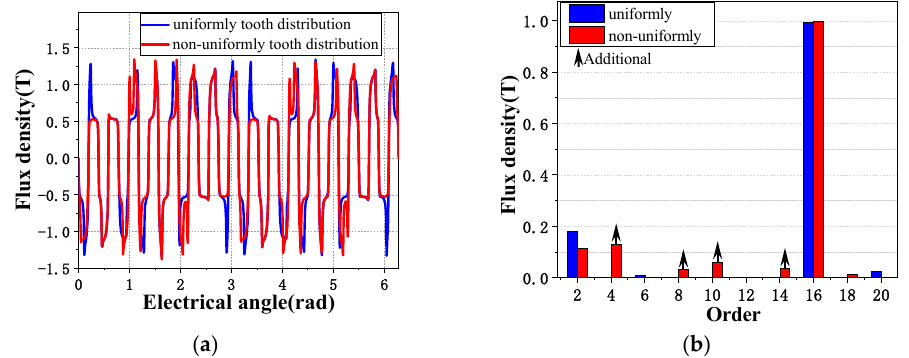
Figure 14. Comparison of airgap flux density by FEM: ( a ) flux density waveform; ( b ) spectra of FFT. The back-EMF is simulated in no-load condition at 50 rpm in Figure 15a. The elec- tromagnetic torque is compared in Figure 15b with the rated current of 0.4A rms . Table 5 compares the performance of two topologies, showing that the proposed machine with non-uniform tooth distribution has a relatively improved performance. Back-EMF and average torque are improved by 24.7% and 23.9%, respectively. Even with additional flux density harmonics, the torque ripple ratio of proposed topology still drops, due to the in- crease of average torque. The contrast of cogging torque is shown in Figure 16. Figure 16a shows that the cogging torque only increases slightly, proving the effectiveness of the proposed phasors method. The FFT results in Figure 16b present that the 6th harmonic is not increased due to the offset of grouping phases, while the 12th and 18th components have been slightly increased caused by the optimization of offset Figure 15. Comparison of performance at 50 rpm by FEM: ( a ) back-EMF; ( b ) electromagnetic torque with rated 0.4A rms current.